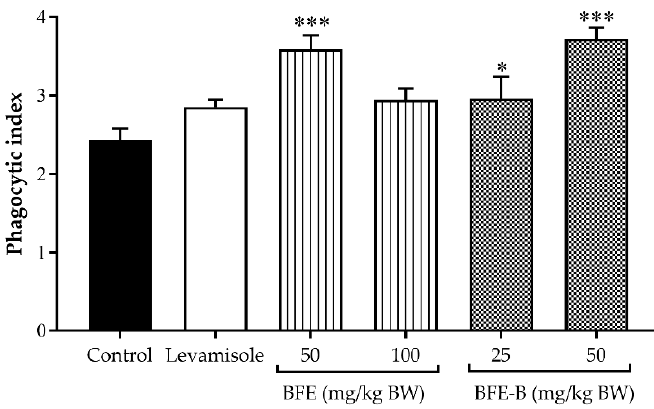
Figure 3. Effect of water-soluble bengkoang ( P. erosus ) fiber extract (BFE) and fiber fraction B (BFE-B) on the phagocytic index of peritoneal macrophages of mice induced by hepatitis B vaccine. The data represent the mean ± SEM of five independent measurements. Significant differences compared with the control are determined at * p < 0.05 and *** p < 0.001. Table 1. Effect of water-soluble fibers of P. erosus (BFE and BFE-B) on the phagocytic capacity of peritoneal macrophages of mice induced by hepatitis B vaccine.